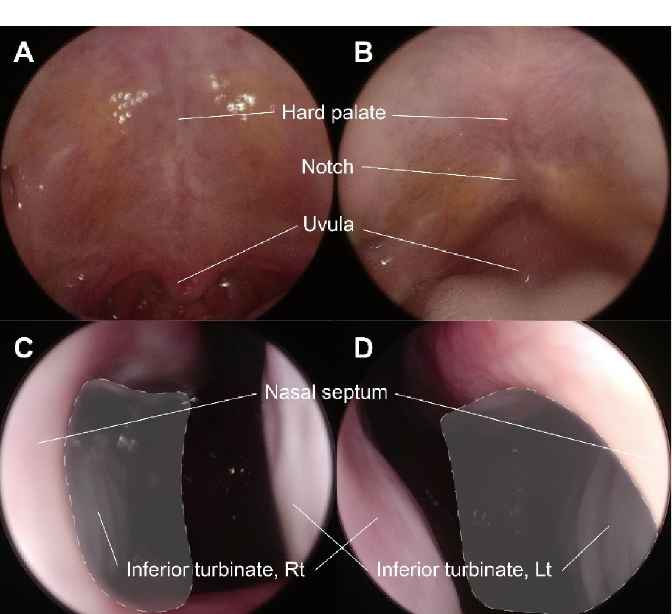
Figure 3. Representative nasal endoscopy images of a patient with occult submucosal cleft palate. ( A ) Normal hard palate (without zona pellucida) and uvula in the resting state and ( B ) during phonation. Vomer deformity in the inferior-posterior nasal septum defect. Bilateral inferior turbinates in a single field. ( C ) Nasal endoscopy of the Lt nostril. ( D ) Nasal endoscopy of the Rt nostril. Gray areas with dotted marginal lines are defective portions of the nasal septum. Lt left, Rt